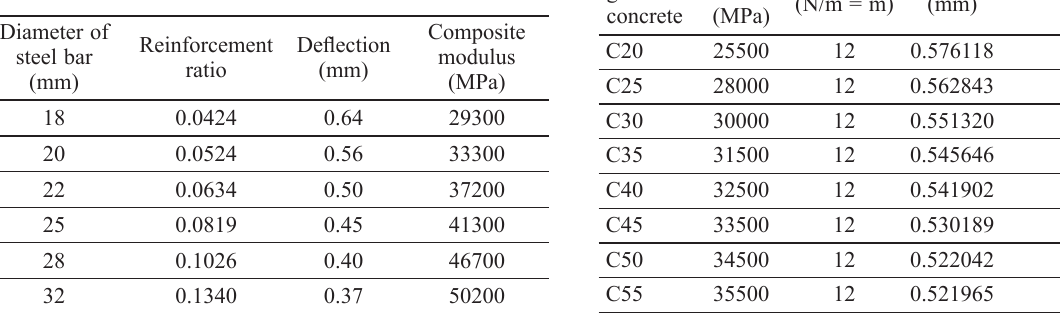
Table 4. Deflection and composite elastic modulus under different concrete strength grade Strength grade of